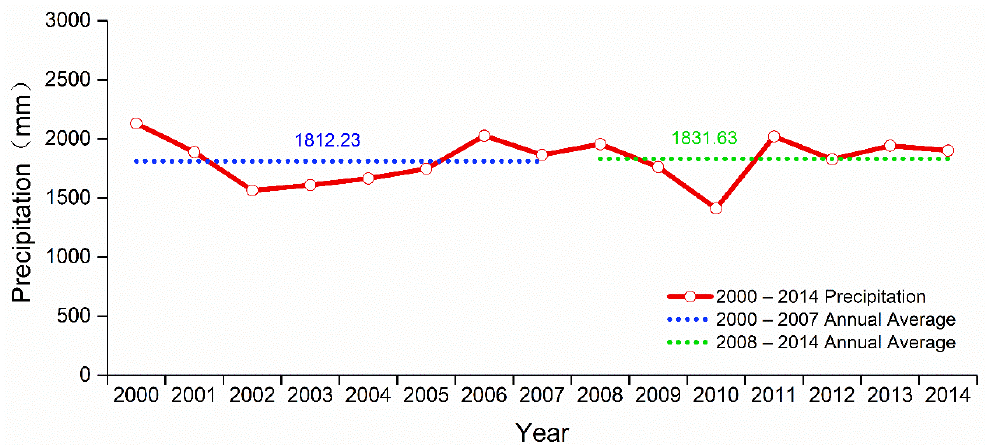
Figure 7. Variations in the Annual Precipitation over the Tonle Sap Lake Basin.